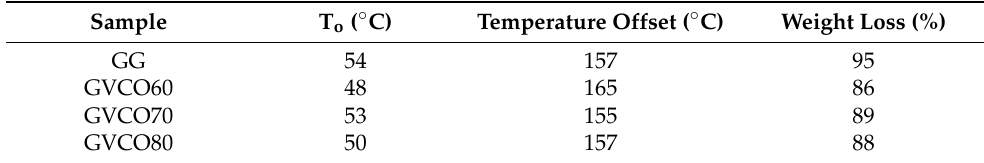
Table 3. Thermal gravimetric properties of gellan gum (GG) and GVCO